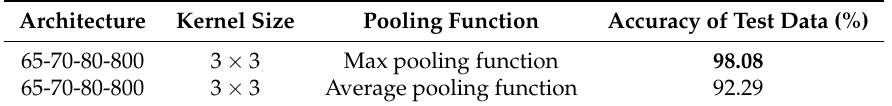
Table 3. The recognition accuracy comparison for pooling functions. The boldface entries represent the highest